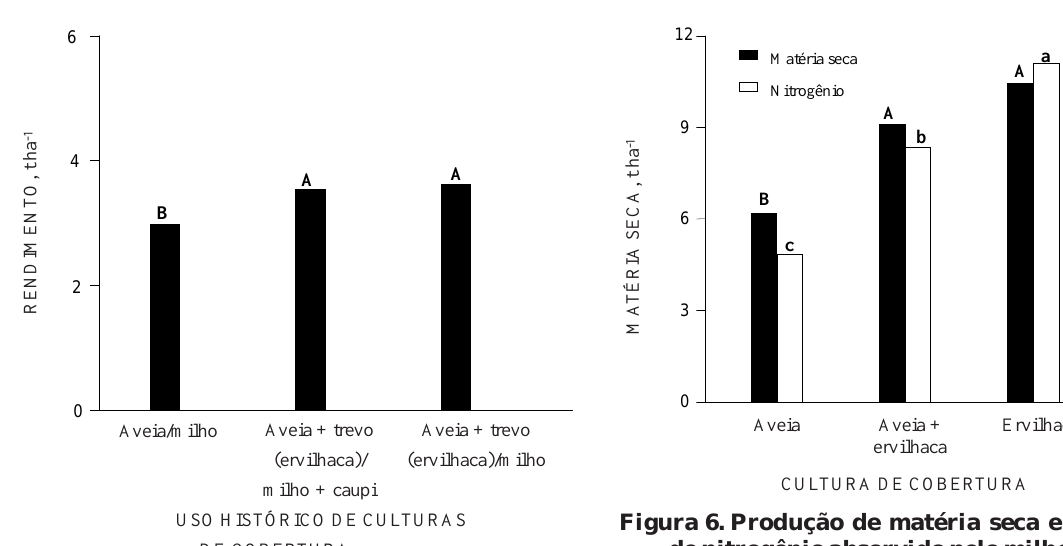
Figura 5. Rendimento de grãos de milho na ausência de cultura de cobertura antecedente em três históricos de uso do solo, considerando média de três sistemas de preparo. Letras maiúsculas comparam o rendimento entre histórico de uso do solo pelo teste de Duncan a 5%.